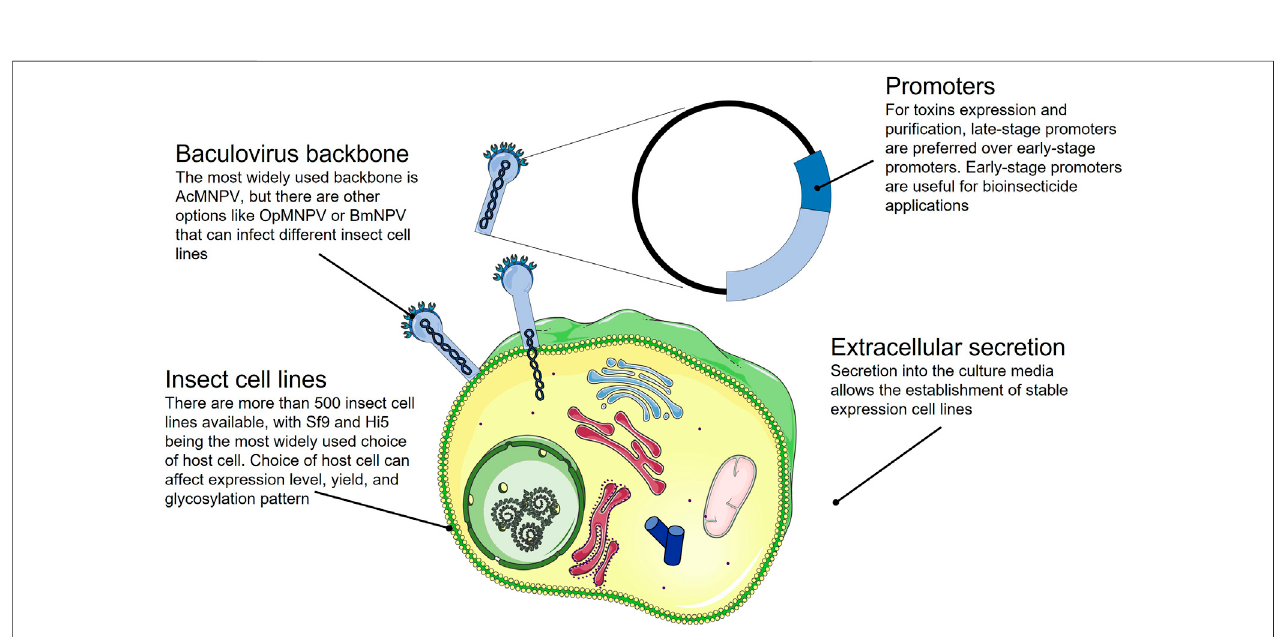
FIGURE 5 | Summary of the strategies available for the expression of correctly folded toxins in a baculovirus insect cell expression system.